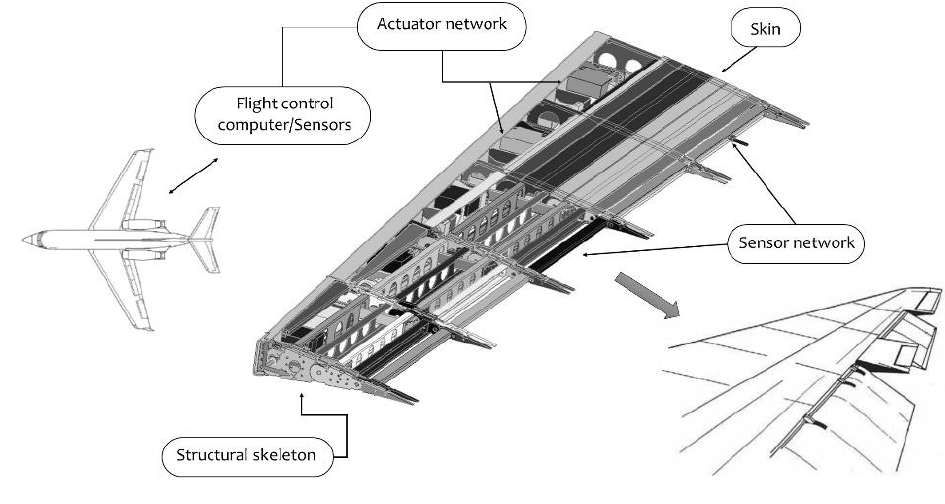
Figure 1. Schematics of the morphing wing device subsystems.